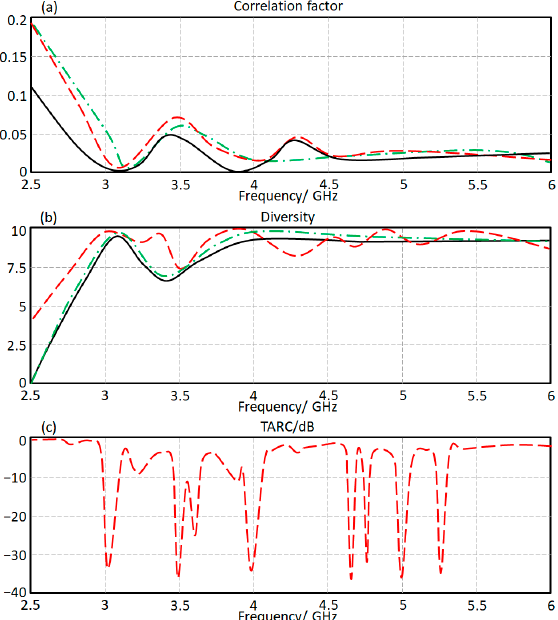
Figure 12. Antenna array performance in terms of: ( a ) correlation, ( b ) diversity, and ( c ) TARC. C. Antenna Radiation Patterns The proposed antenna radiation patterns are measured at 3.6 GHz, 3.9 GHz, and 4.9 GHz, as shown in Figure 13. It is found that the proposed antenna provides a significant enhancement in the directivity. The measured and simulated results agree well with each other.